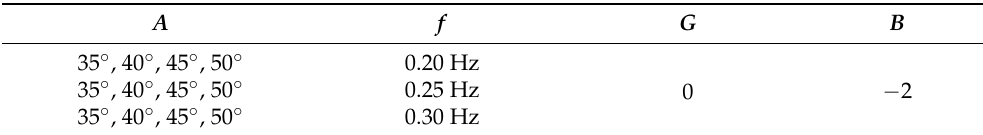
Table 2. High-level control command in conventional nondeformable mode.